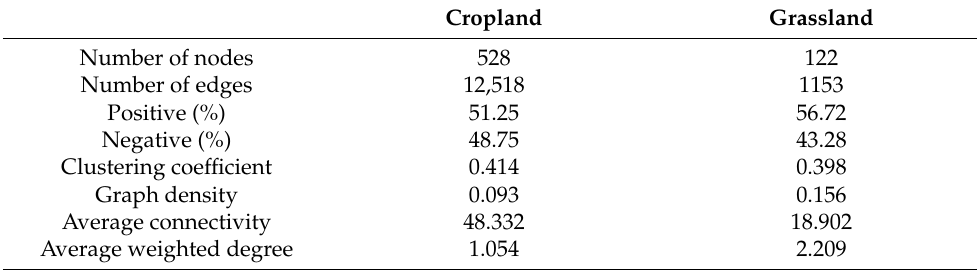
Table 1. Key topological features of co-occurrence networks of core bacterial taxa in the soil of cropland and grassland.